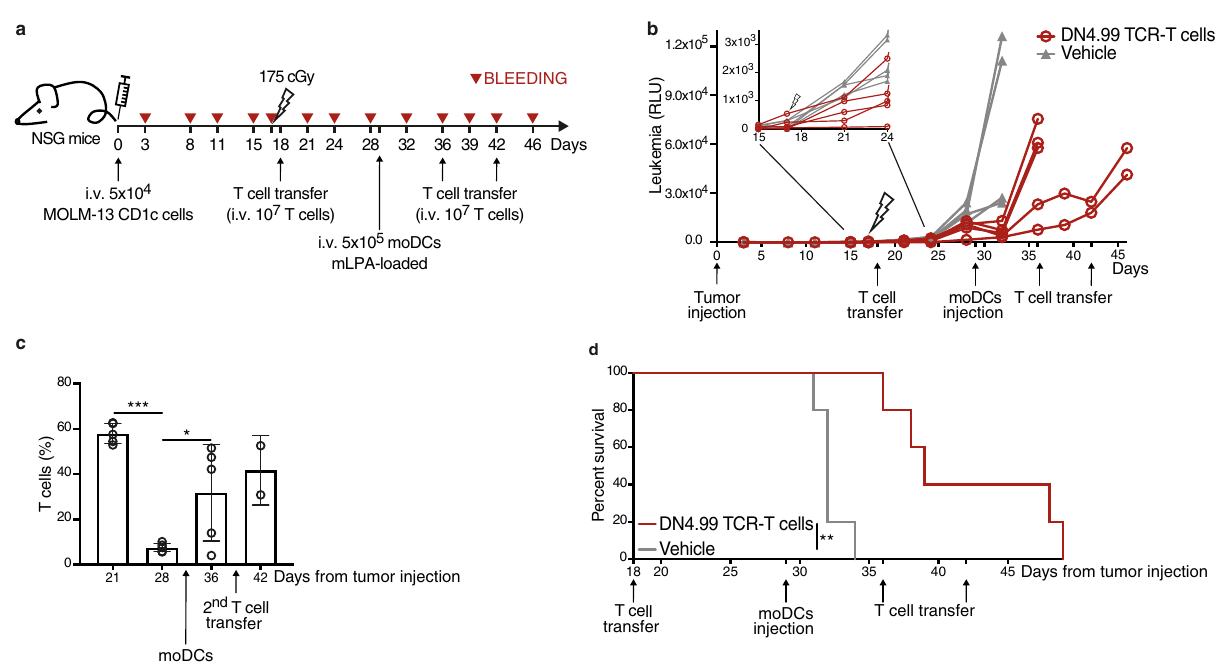
Fig. 9 mLPA-antigen cellular immunization sustains the in vivo anti-leukemia ef fi cacy of DN4.99 TCR-T cells against CD1c + acute leukemia MOLM-13. a DN4.99 TCR-transduced T (DN4.99 TCR-T) cells restrict MOLM-13 leukemia progression in vivo. NOD.Cg-Prkdcscid IL- 2rgtm1Wjl/SzJ (NSG)